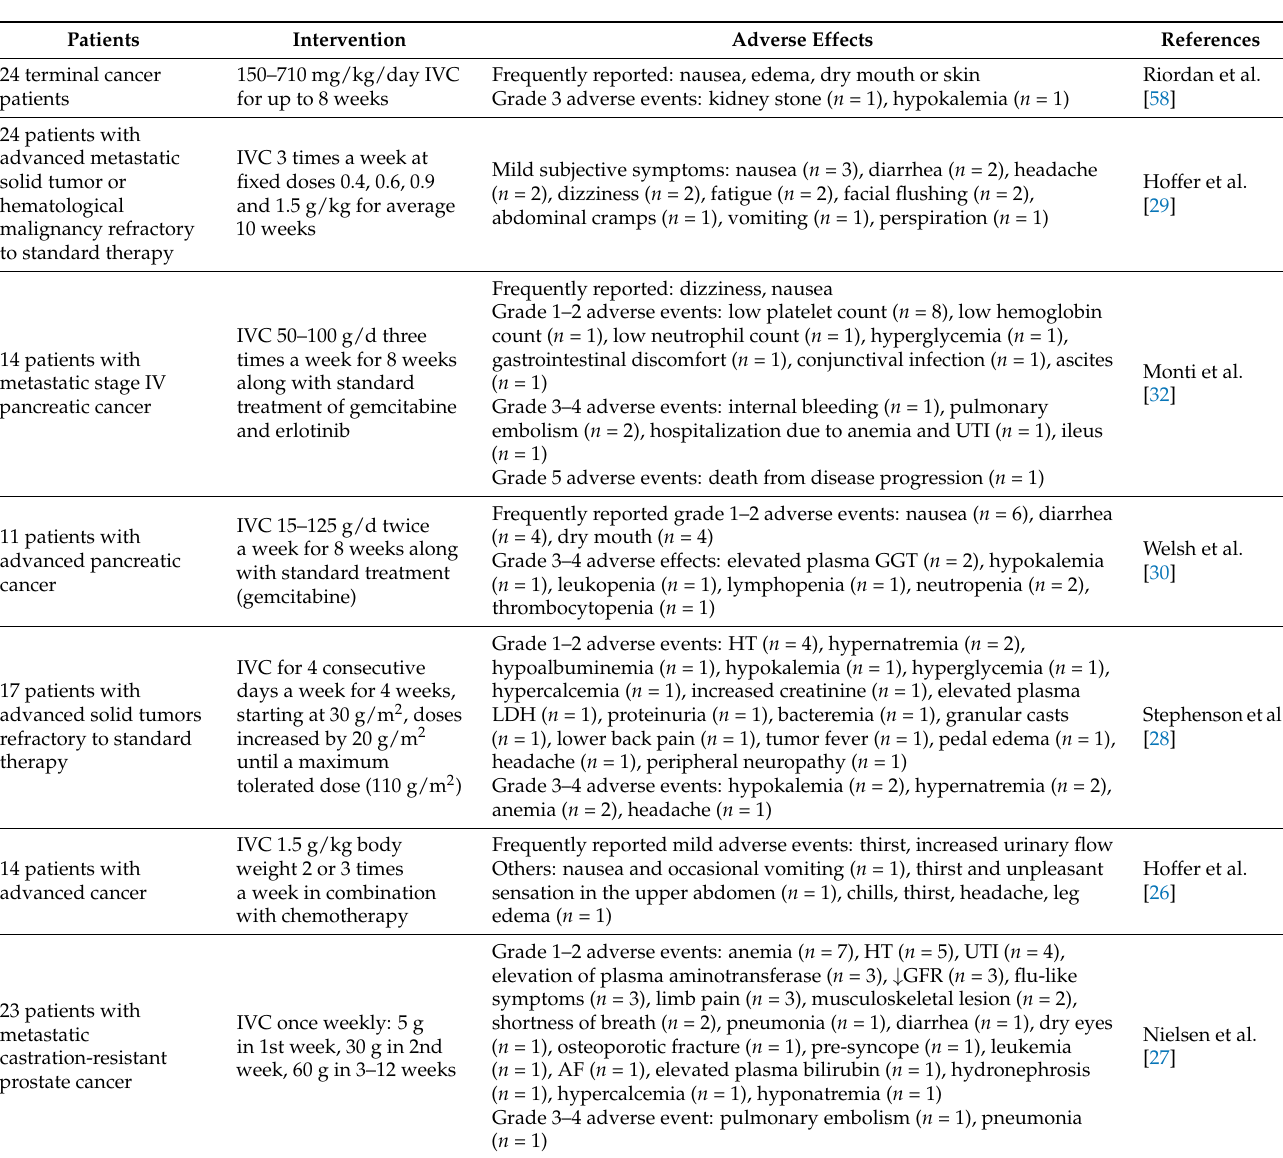
Table 3. Adverse effects of high-dose intravenous vitamin C (IVC) in patients with advanced cancer observed in prospective